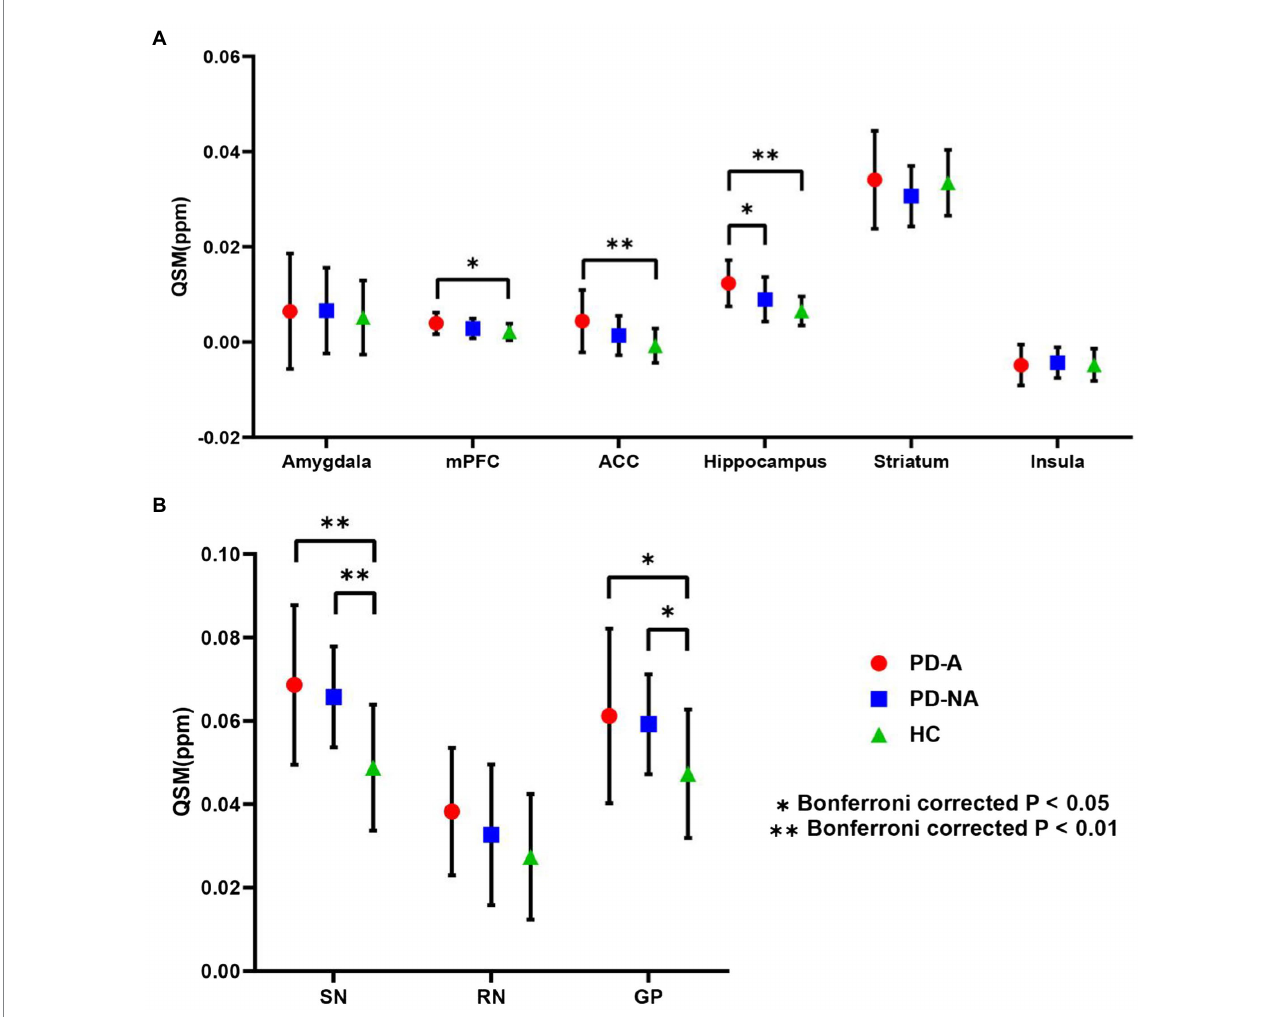
FIGURE 3 ROI-based QSM analysis. Regional mean QSM values in (A) the fear circuit ROIs and (B) iron deposition-based ROIs. Error bars signify the standard error of the mean. Stars denote significant differences between the groups: * Bonferroni-corrected p < 0.05; ** Bonferronicorrected p < 0.01. QSM, quantitative susceptibility mapping; ROI, region of interest; PD-A, Parkinson’s disease with anxiety; PD-NA, Parkinson’s disease without anxiety; HC, healthy control; mPFC, medial prefrontal cortex; ACC, anterior cingulate cortex; SN, substantia nigra; RN, red nucleus; GP, globus